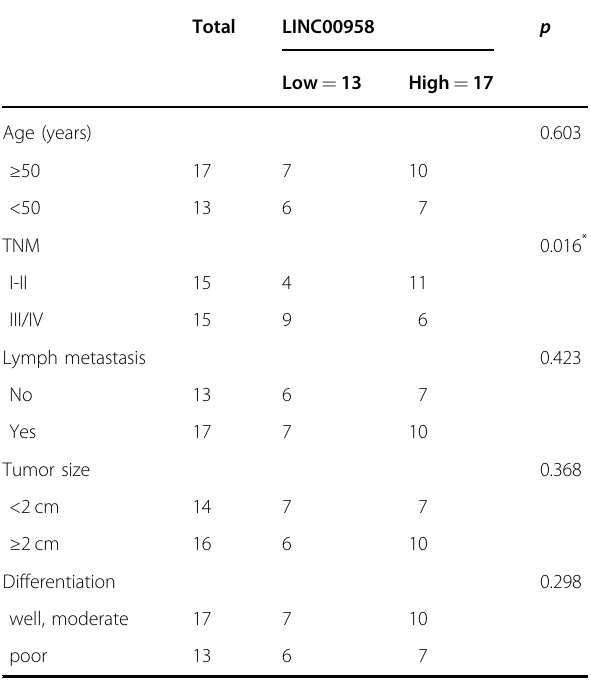
Table 1 Clinicopathological feature of BC patients with high/low expression of